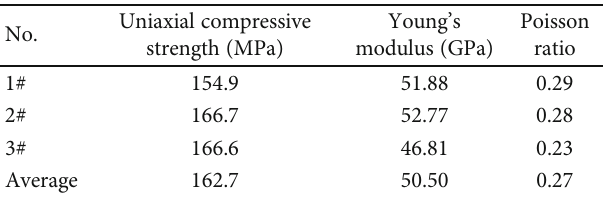
Figure 1: True triaxial experimental host and hydraulic control system: (a) force and deformation acquisition system; (b) acoustic emission monitoring system; (c) high-speed image recording system. Table 1: Rock uniaxial compression test